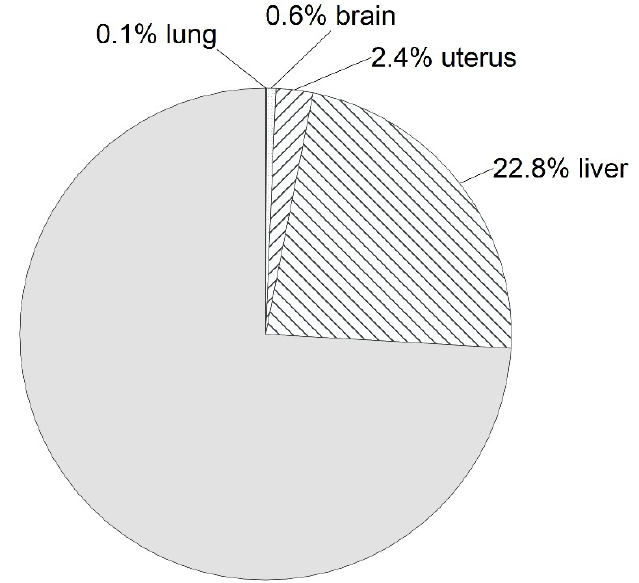
Figure 3. The 3 mg tamoxifen dose distribution between organs with respect to their weights at 4 h after injection.